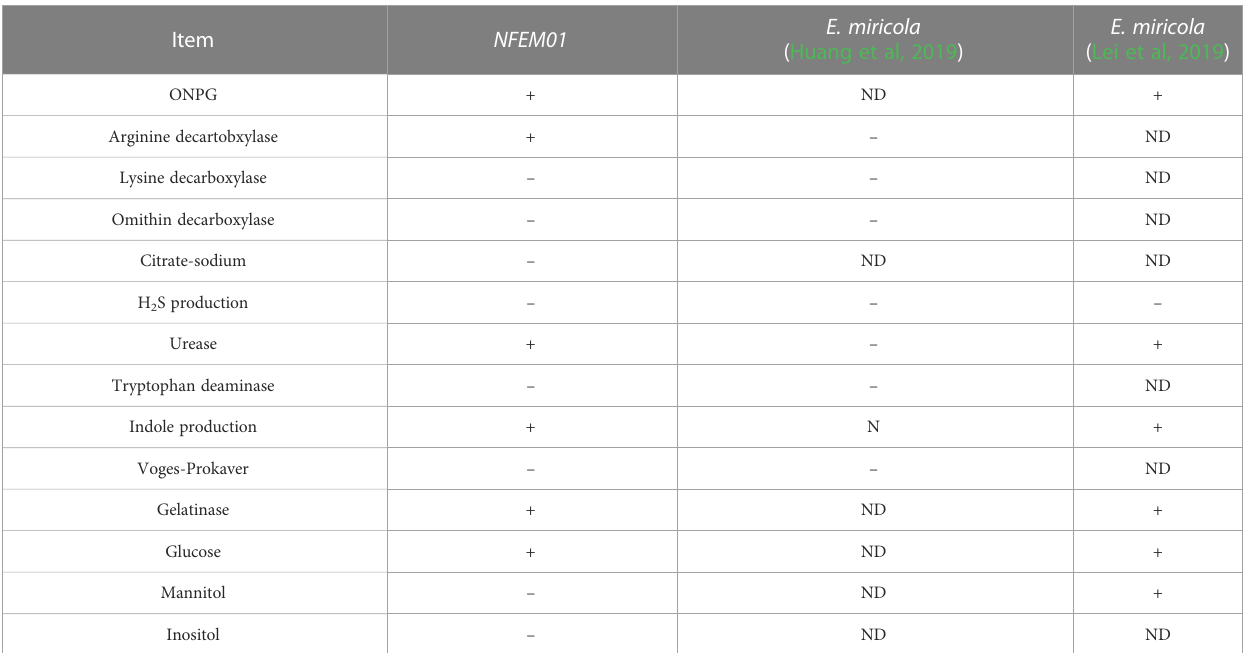
TABLE 2 Physiological and biochemical characteristics of NFEM01 .